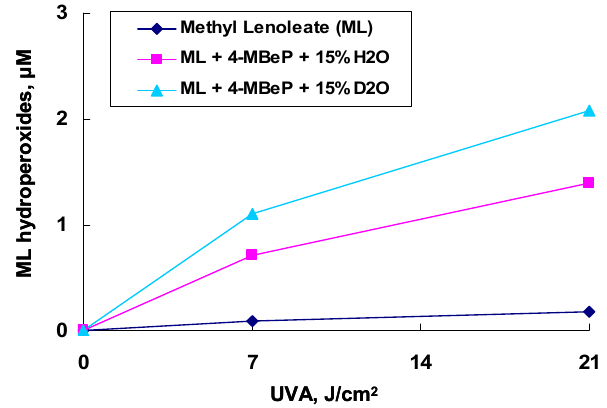
O on the peroxidation 2